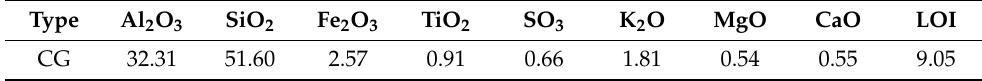
Table 3. Chemical composition (wt%) of